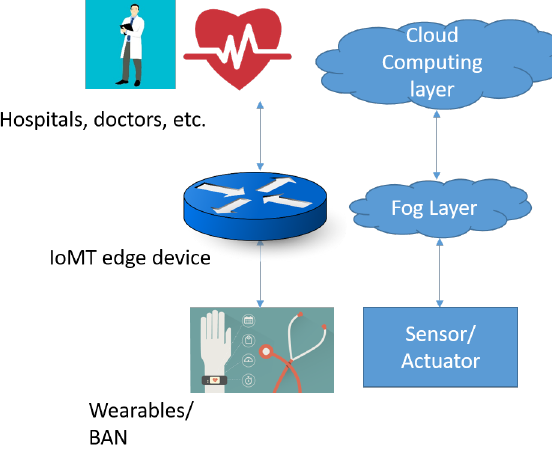
Figure 3. Fog-based e-health